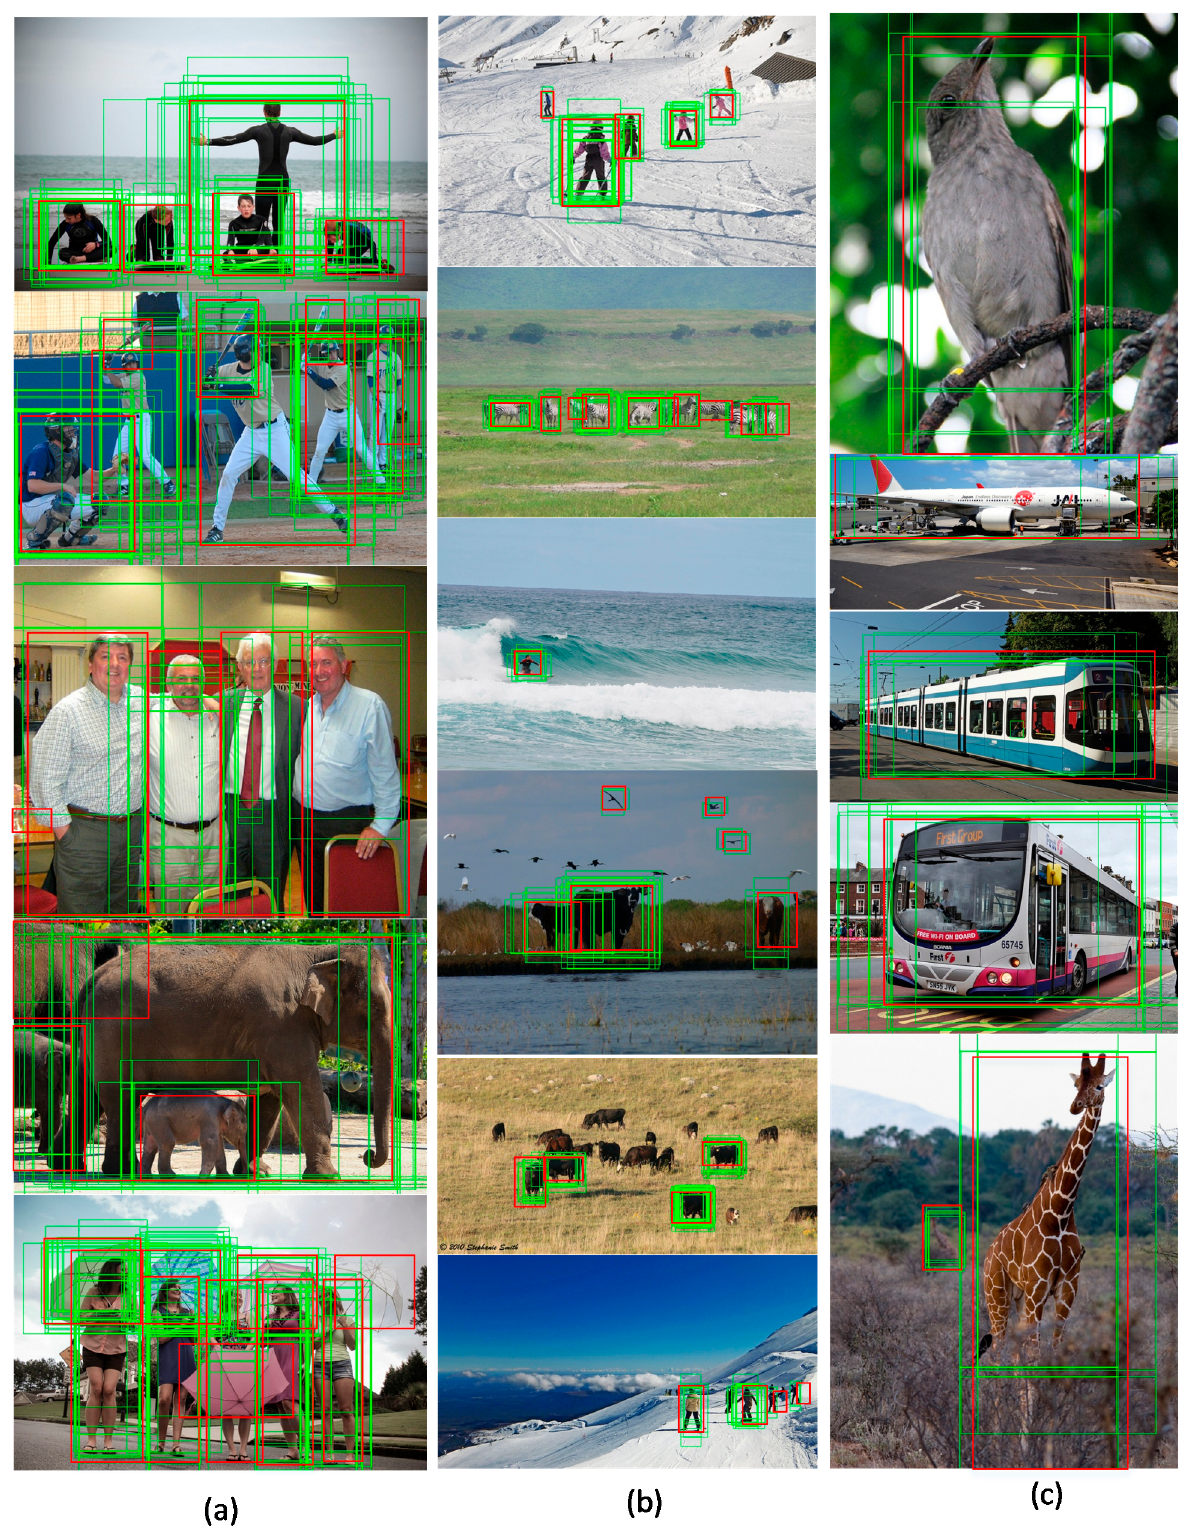
Figure 7. Visualization results of predicted anchors (green boxes) and ground-truth boxes (red boxes) in DA-RetinaNet. ( a ) Input images with dense objects; ( b ) input images with small-scale objects; ( c ) input images with extremely wide objects.